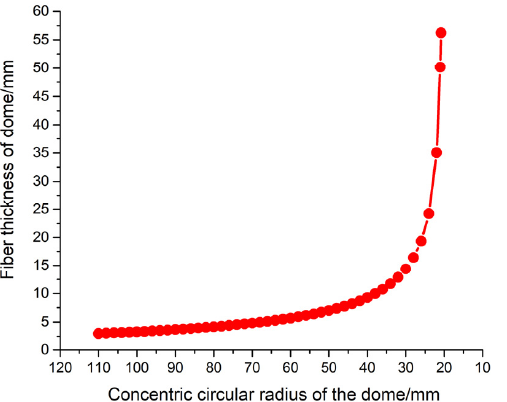
Figure 3. The variation trend of dome fi ber thickness according to the concentric circle radius.